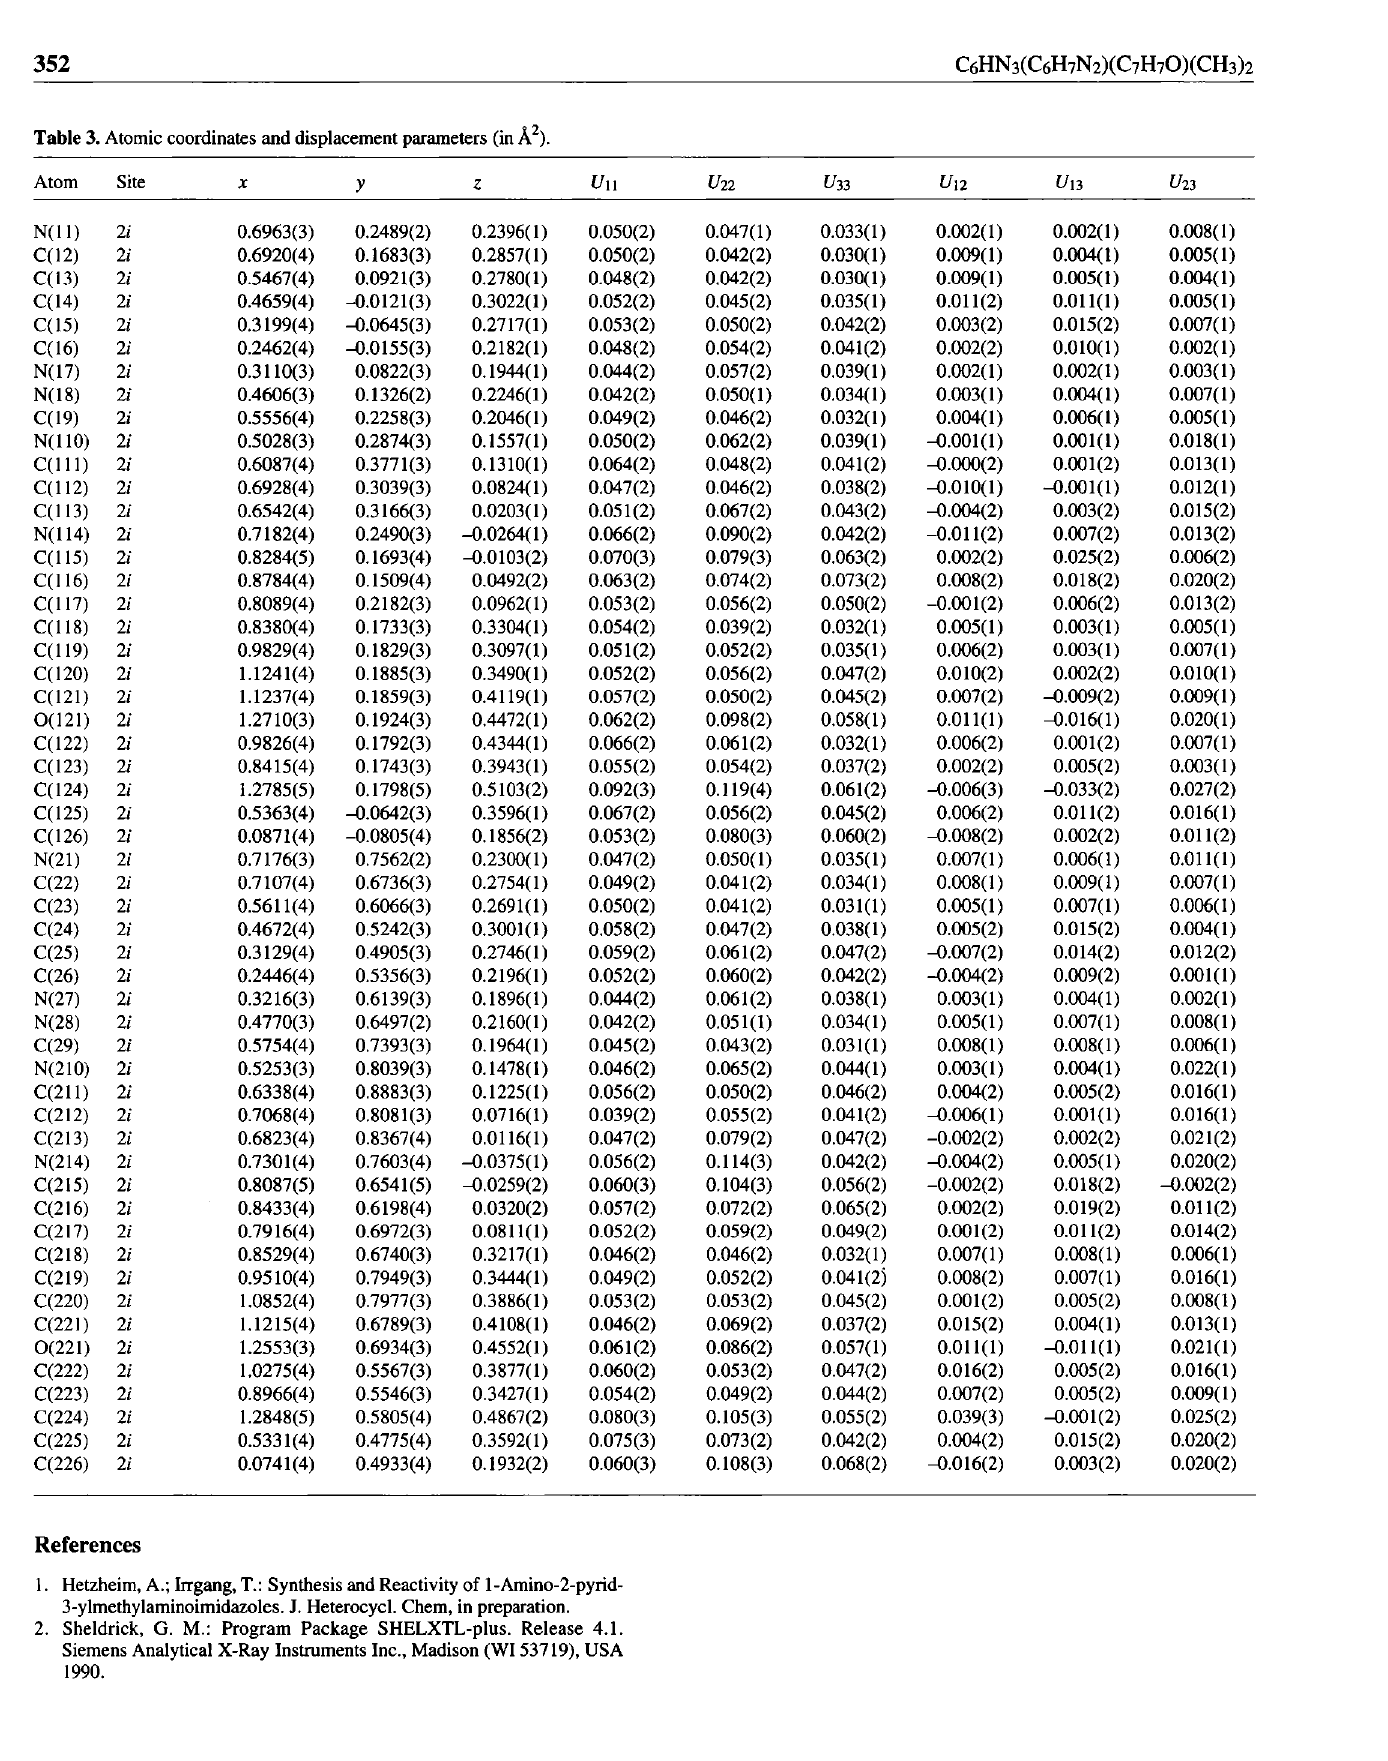
Table 3. Atomic coordinates and displacement parameters (in Â 2